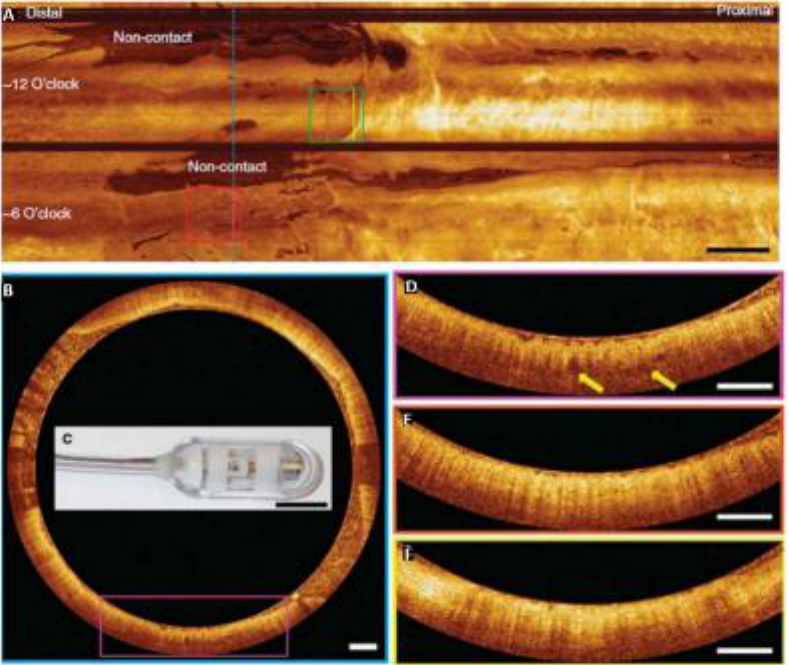
Figure 4. ( A ) En face OCT obtained below esophageal surface. Only the distal 12 cm out of 24 cm data are shown. ( B ) Representative cross-section (blue) from EMR region (red) ( C ). ( D ) Enlargement (pink) from ( B ) showing layer effacement, surface signal greater than subsurface, and multiple dilated glands (arrows). ( E ) Cross-section (brown) showing layered BE, which is likely non-dysplastic. ( F ) Cross-section (yellow) showing the squamo – columnar junction at a tongue of BE. Inset scale bars 1 mm. Reprinted with permission from [66]. Copyright 2016 Wolters Kluwer Health, Inc: American Journal of Gastroenterology.